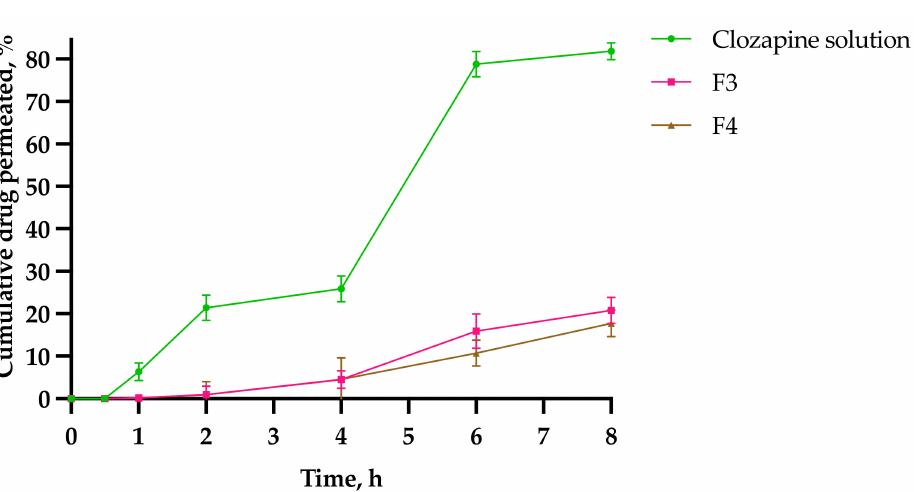
Figure 15. Cumulative percentage of clozapine permeation across nasal mucosal tissues from clozap- ine solution, F3 and F4 gel matrix at 34 ◦ C ( n = 3 ± SD).